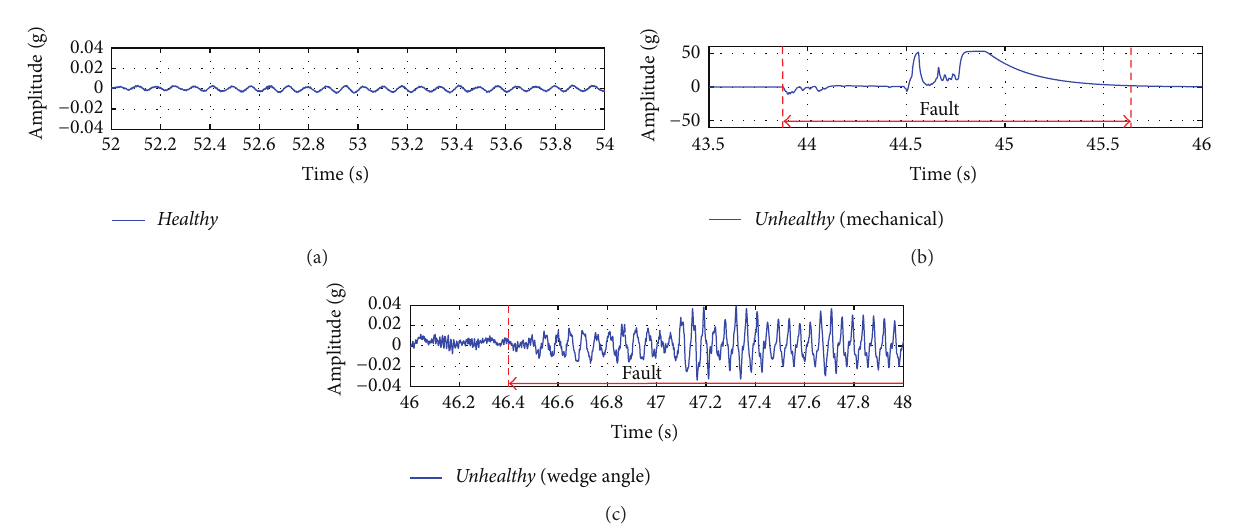
Figure 12: Vibration of the “ healthy ” lapping process.